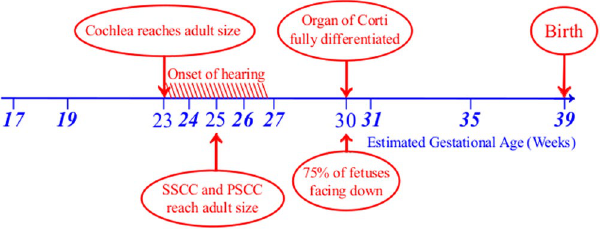
Figure 1. Estimated gestational age of collected specimens (bold italic) within the time-course of inner ear embryonic